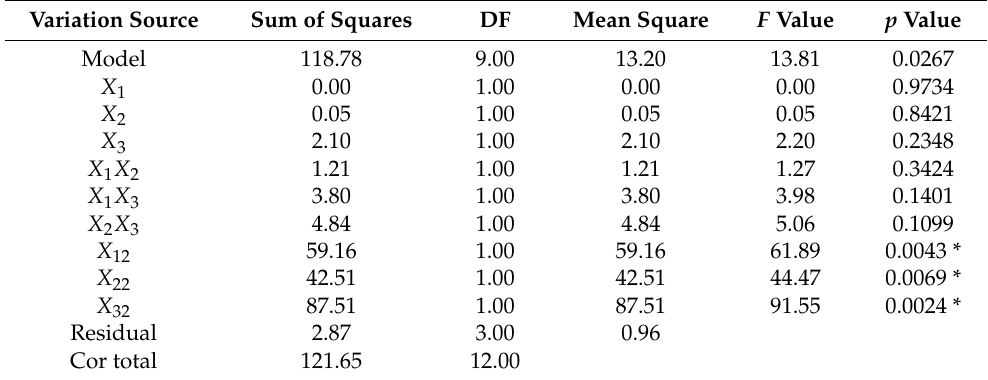
Table 6. Variance analysis results for soil flatness of seedbed preparation machine parameter opti- mization test.